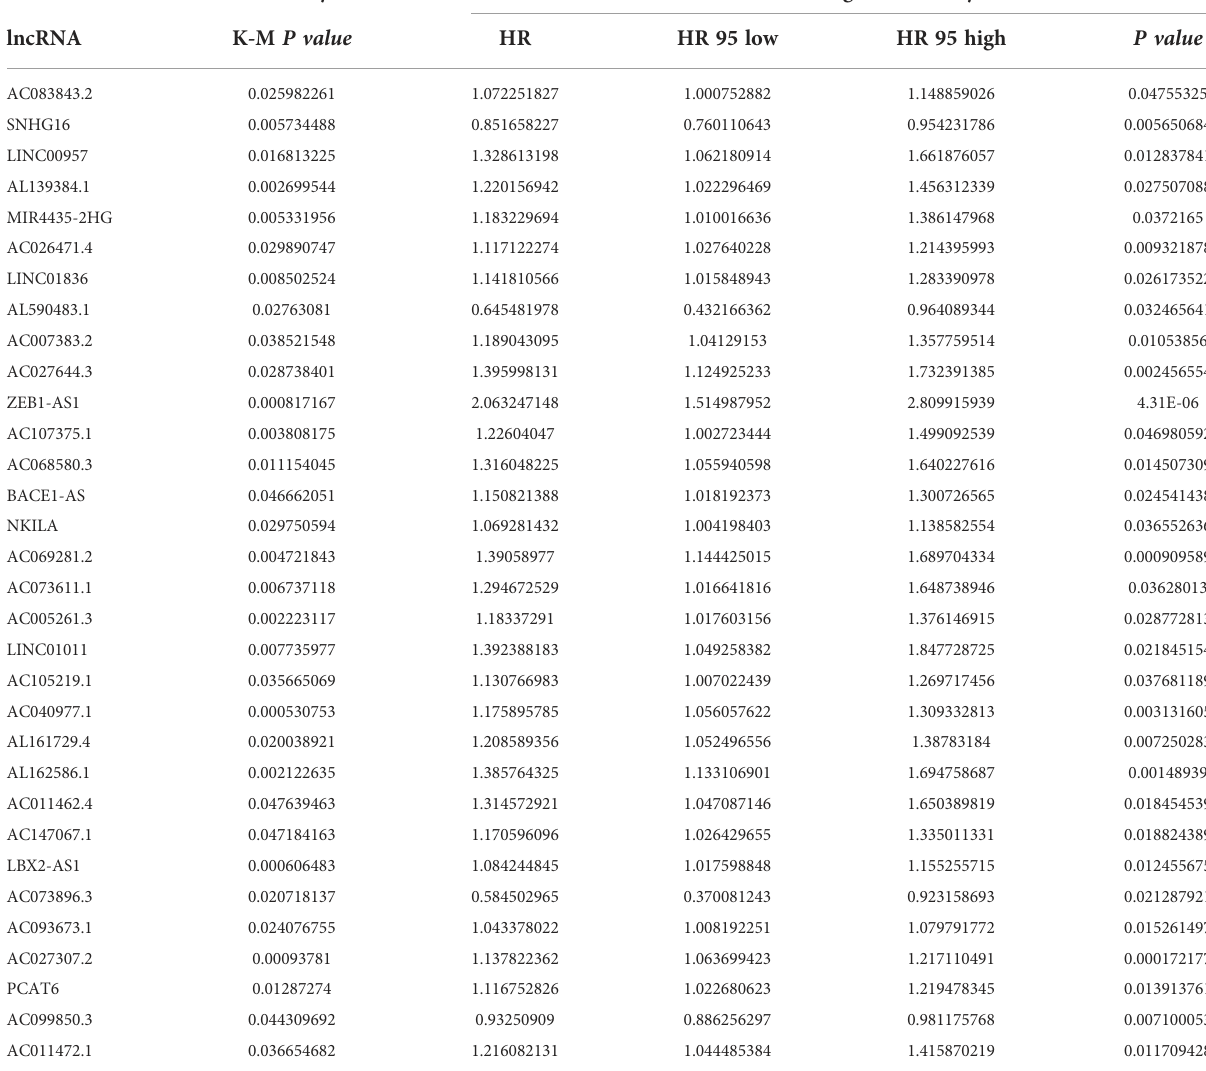
TABLE 1 Univariate Cox regression analyses and K-M analysis in patients with CRC.